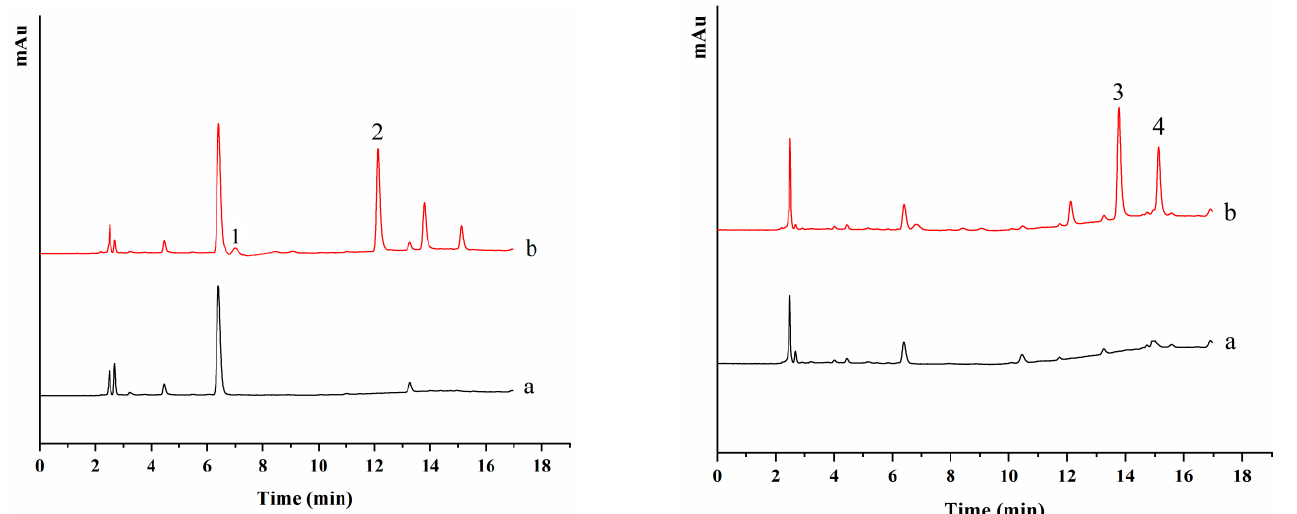
Figure 9. HPLC chromatograms from DAD of four neonicotinoid insecticides in real tap water samples after DME without spiking (a) and with spiking (b); measurement wavelength 270 nm ( left ) and measurement wavelength 244 nm ( right ). Peak identification: (1) nitenpyram (2) imidacloprid (3) acetamiprid and (4) thiacloprid. Table 3. Determination of four neonicotinoid insecticides and method recoveries in real water